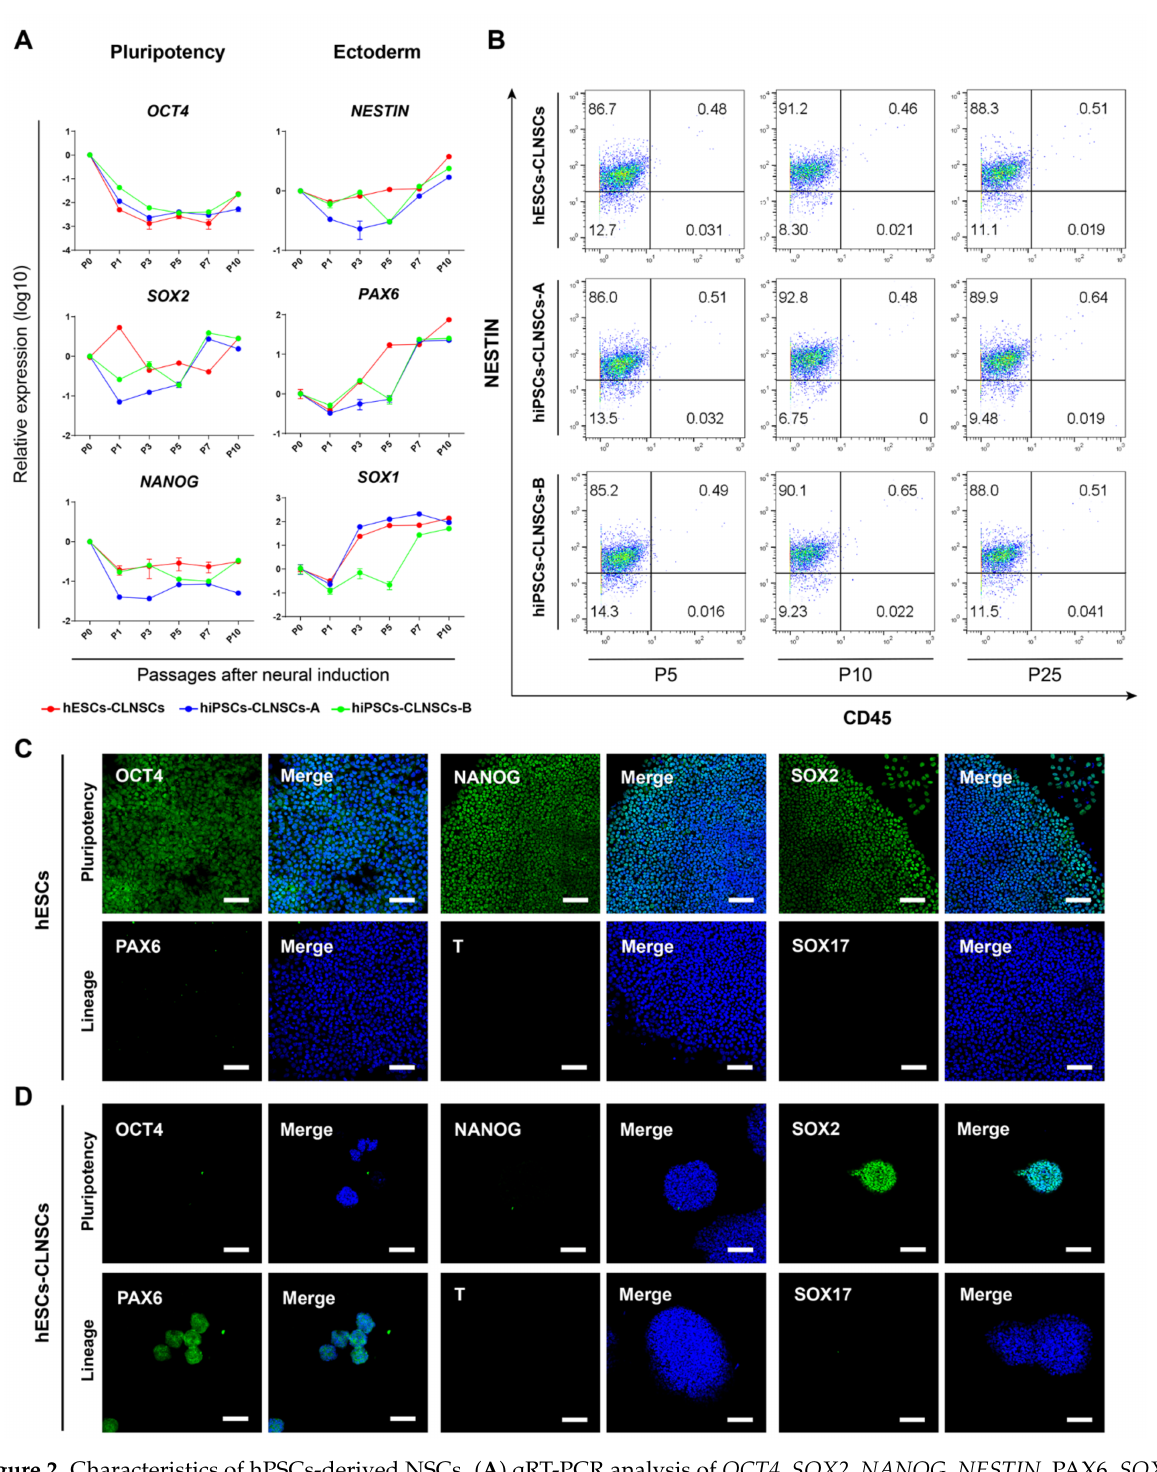
Figure 2. Characteristics of hPSCs-derived NSCs. ( A ) qRT-PCR analysis of OCT4 , SOX2 , NANOG , NESTIN , PAX6, SOX1 in hPSCs after neural induction. Relative mRNA expression values were normalized to GAPDH . Error bar indicates the mean ± SD of three independent experiments in duplicate. ( B ) Detection of neural marker NESTIN and pan-leukocyte marker CD45 expression by flow cytometry in Passage 5, Passage 10, and Passage 25 of CLNSCs derived from hPSCs. ( C ) Immunofluorescence staining for pluripotent markers OCT4, SOX2, and NANOG and lineage markers PAX6, T, and SOX17 in hESCs (Passage 28), scale bar: 100 µ m. ( D ) Immunofluorescence staining for pluripotent markers OCT4, NANOG, and SOX2 as well as neural marker PAX6, mesodermal marker T, and endodermal marker SOX17 in hESC-derived CLNSCs (Passage 25), scale bar: 100 µ